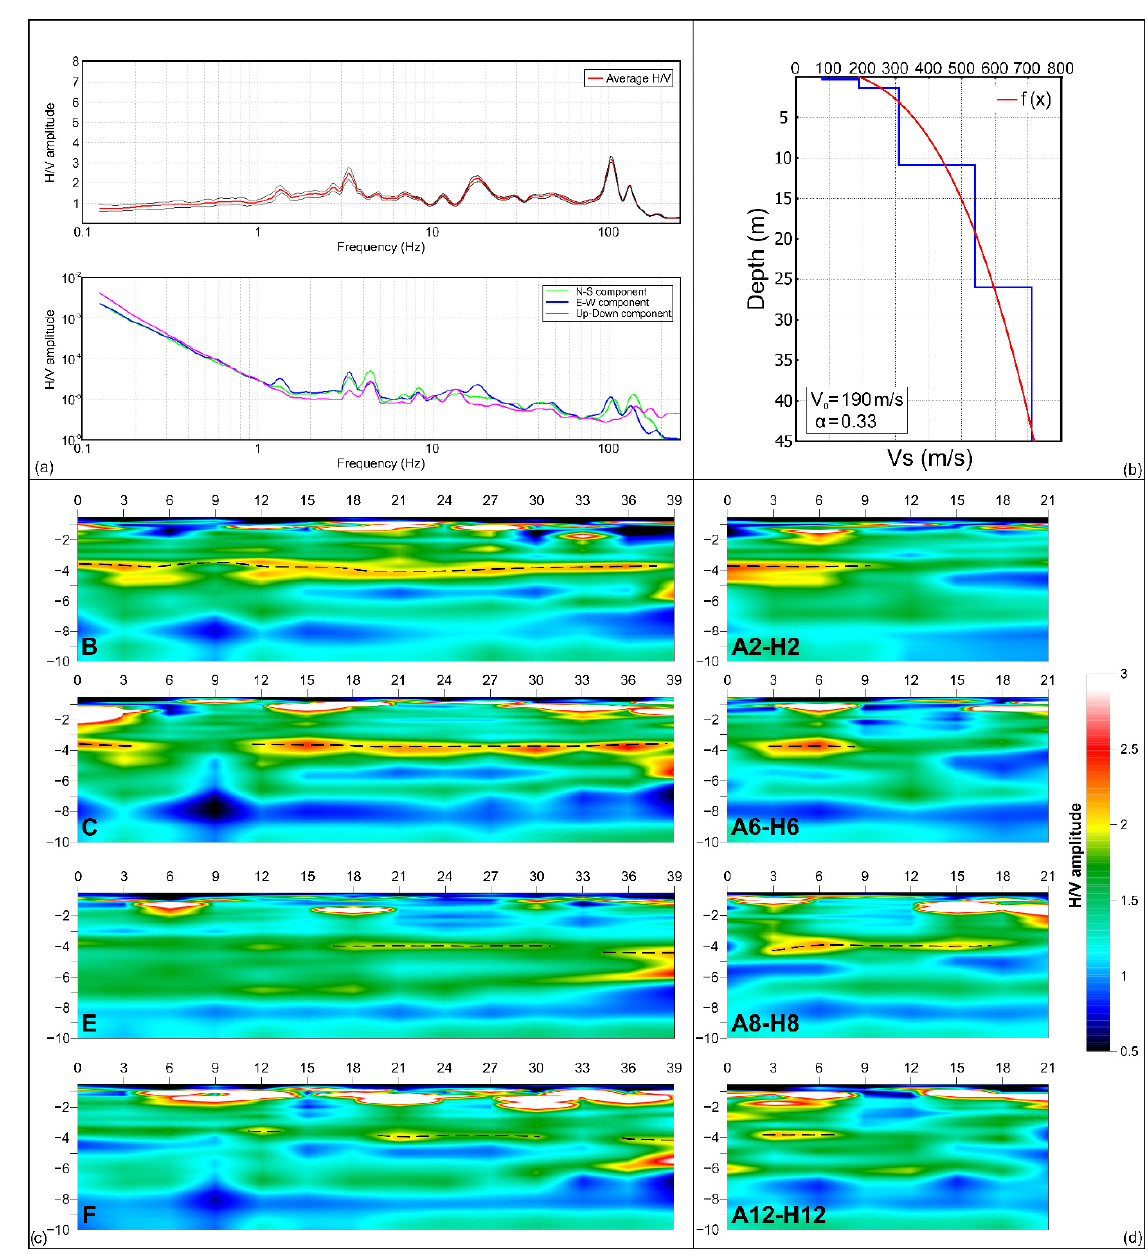
Figure 10. ( a ) Example of H/V spectrum obtained from ambient noise processing and relative Fourier spectral components graph; ( b ) Vs-depth profile obtained by MASW data processing, the red curve is the function that fits the data characterised by minimum misfit with velocity profile; examples of longitudinal ( c ) and transversal ( d ) impedance contrast sections (see Figure 4 for location). The dotted lines highlight an impedance contrast observed in all the sections.